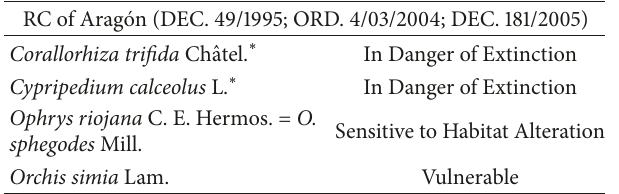
Table 4: Species included in the regional catalogue (R.C.) of Arag´on (DEC. 49/1995; ORD. 2004/03/04). RC of Arag´on (DEC. 49/1995; ORD. 4/03/2004; DEC. 181/2005)